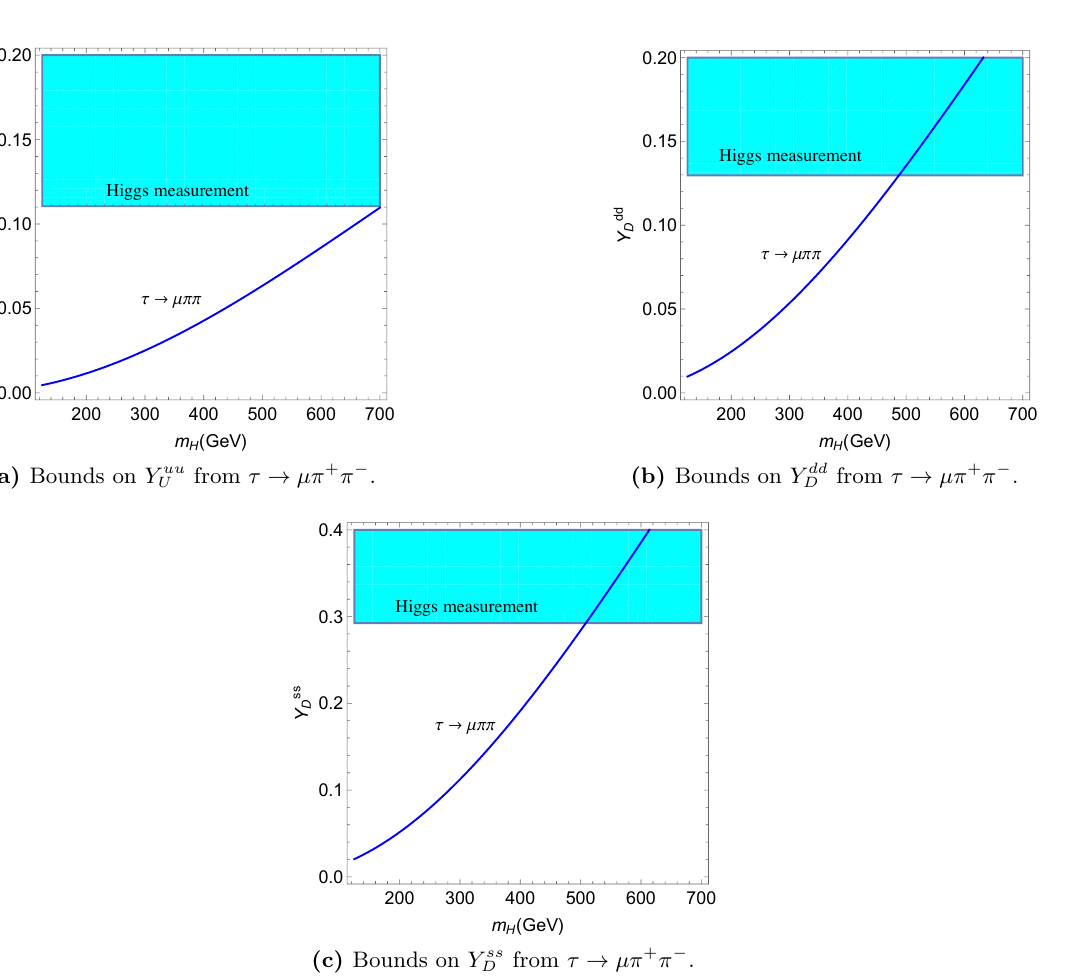
, Y dd and Y dd from (cid:28) U D D !